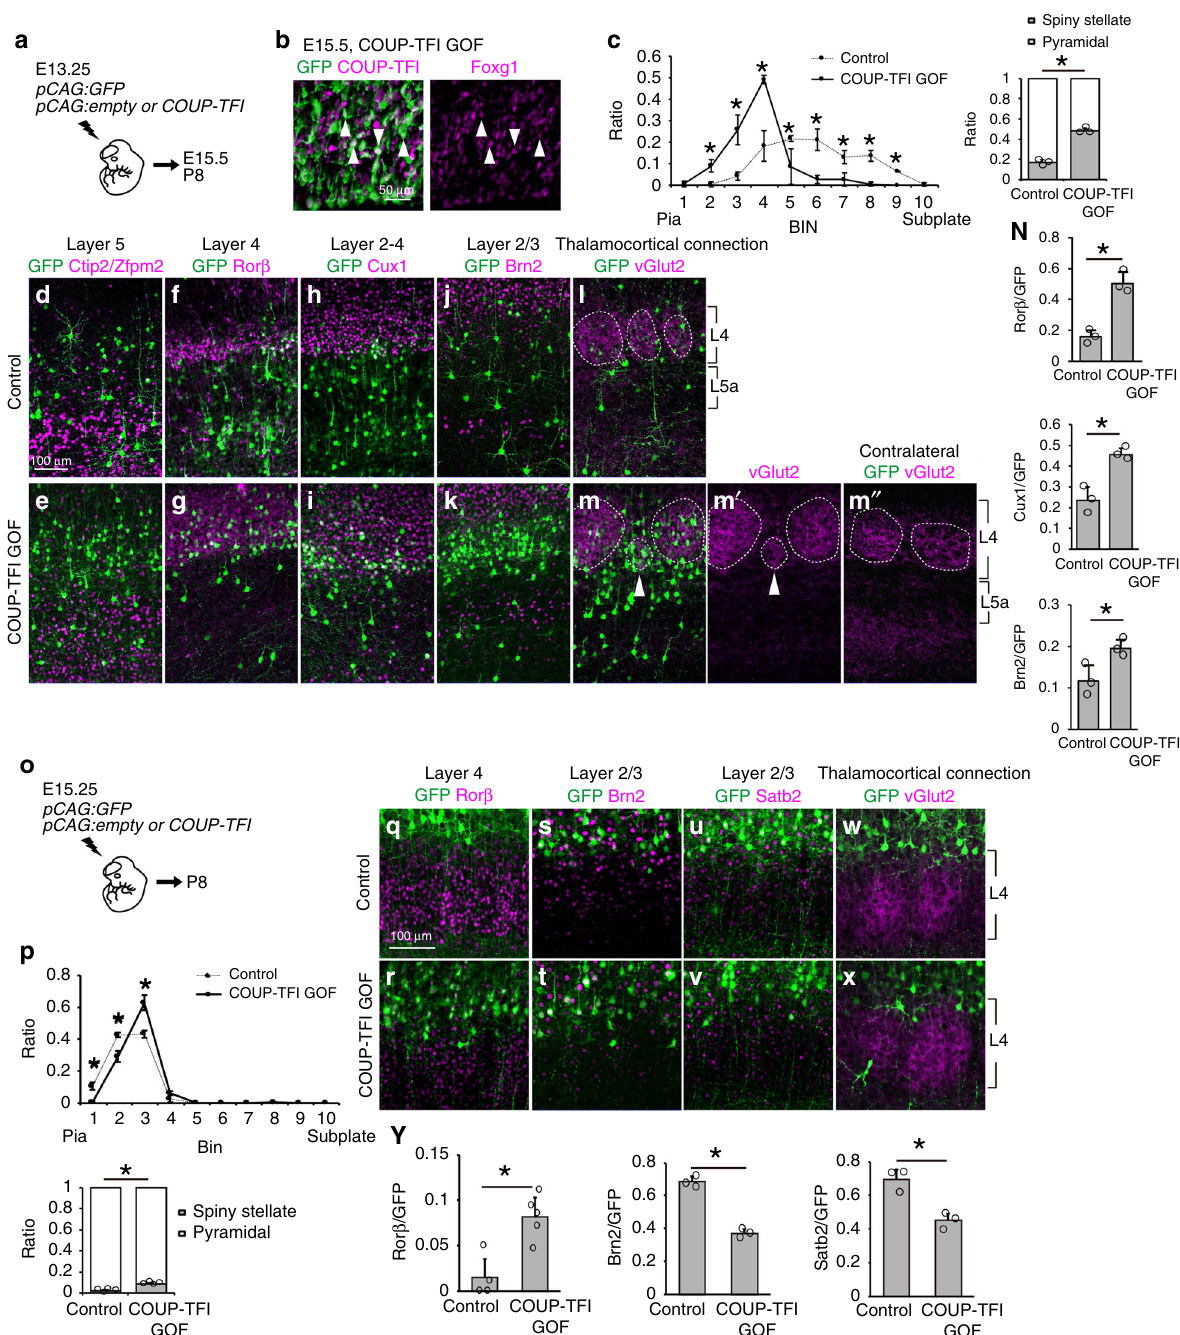
Fig. 6 Ectopic COUP-TFI expression promotes non-layer 4 cells to acquire layer 4 fate. a Schematic diagram of in utero electroporation. Brains were introduced with pCAG:GFP and pCAG: empty (Control) or pCAG:GFP and pCAG:COUP-TFI (COUP-TFI GOF). b Immunostaining of GFP (green), COUP-TFI (red), and Foxg1 (magenta) in E15.5 cortices. Closed arrowheads indicate GFP cells expressing both COUP-TFI and Foxg1. c Quantitative analysis of the distribution of GFP cells in P7 cortices. Cortical plate is divided into 10 BINs from the pia to the subplate. Quantitative analysis of the percentage (±SEM) of GFP cells with spiny stellate or pyramidal morphology. d – m ″ Double immunohistochemistry of P8 cortices for GFP (green) with Ctip2/Zfpm2 (red) ( d , e ), Ror β (red) ( f , g ), Cux1 (red) ( h , i ), Brn2 (red) ( j , k ), and vGlut2 (red) ( l – m ″ ). Dashed lines indicate layer 4 barrel structures. Closed arrowheads indicate ectopic vGlut2-positive thalamocortical presynaptic terminals as compared to the contralateral hemisphere. n Quantitative analysis of the percentage (±SEM) of GFP cells that express Ror β , Cux1 or Brn2. o Schematic diagram of in utero electroporation. Brains were introduced with pCAG:GFP and pCAG: empty (Control) or pCAG:GFP and pCAG:COUP-TFI (COUP-TFI GOF). p Quantitative analysis of the distribution of GFP cells in P7 cortices. Cortical plate is divided into 10 BINs from the pia to the subplate. Quantitative analysis of the percentage (±SEM) of GFP cells with spiny stellate or pyramidal morphology. q – x Double immunohistochemistry for GFP (green) with Ror β (red) ( q , r ), Brn2 (red) ( s , t ), Satb2 (red) ( u , v ), and vGlut2 (red) ( w , x ). y Quantitative analysis of the percentage (±SEM) of GFP cells that express Ror β , Brn2 or Satb2. * indicates P value <0.05 by Student ’ s t -test. Source data are provided as